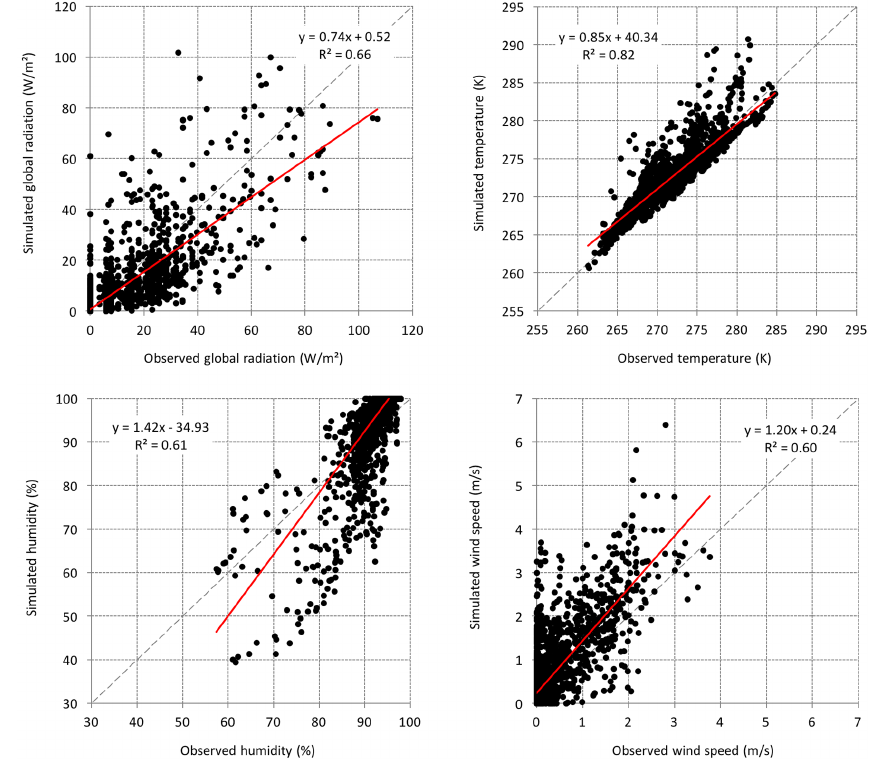
Figure 10. Simulated vs. observed meteorological conditions inside the forest canopy for the winter period 2012/13 at site Vordersteinwald.